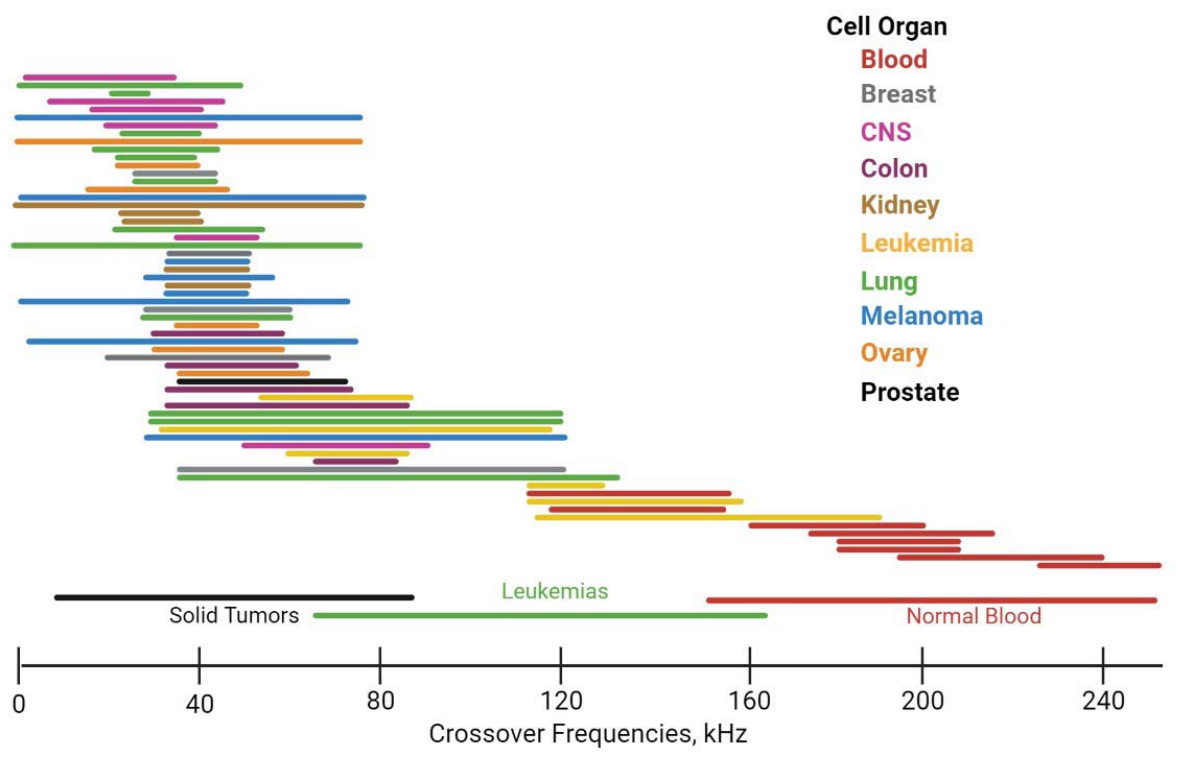
Figure Figure 3. DEP responses of cancer and normal blood cells expressed in terms of first crossover fre ‐ quency.